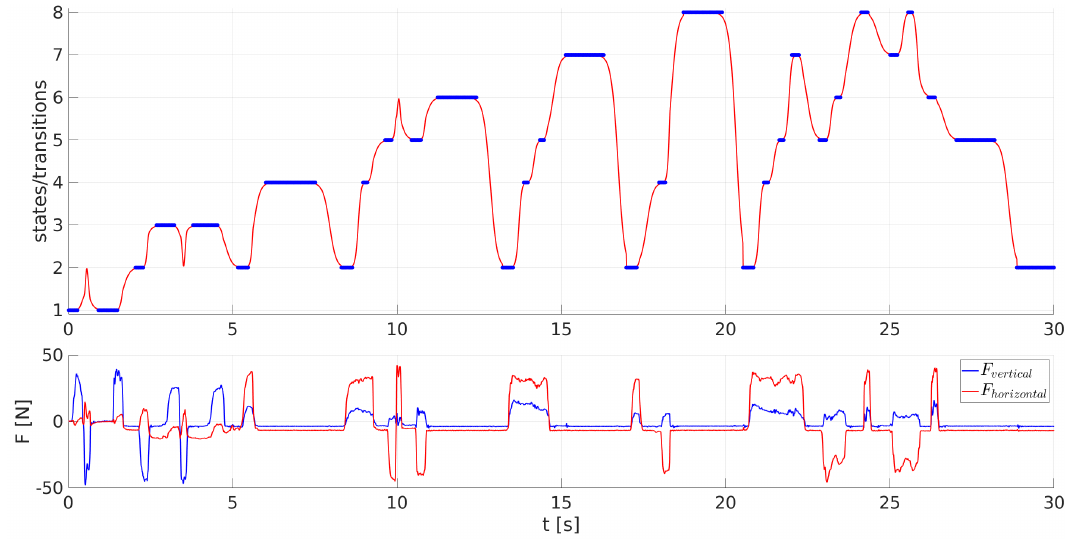
Figure 9. Transitions of the PSS between states 1–8 as a function of time with the forces exerted on the grippers of the humanoid